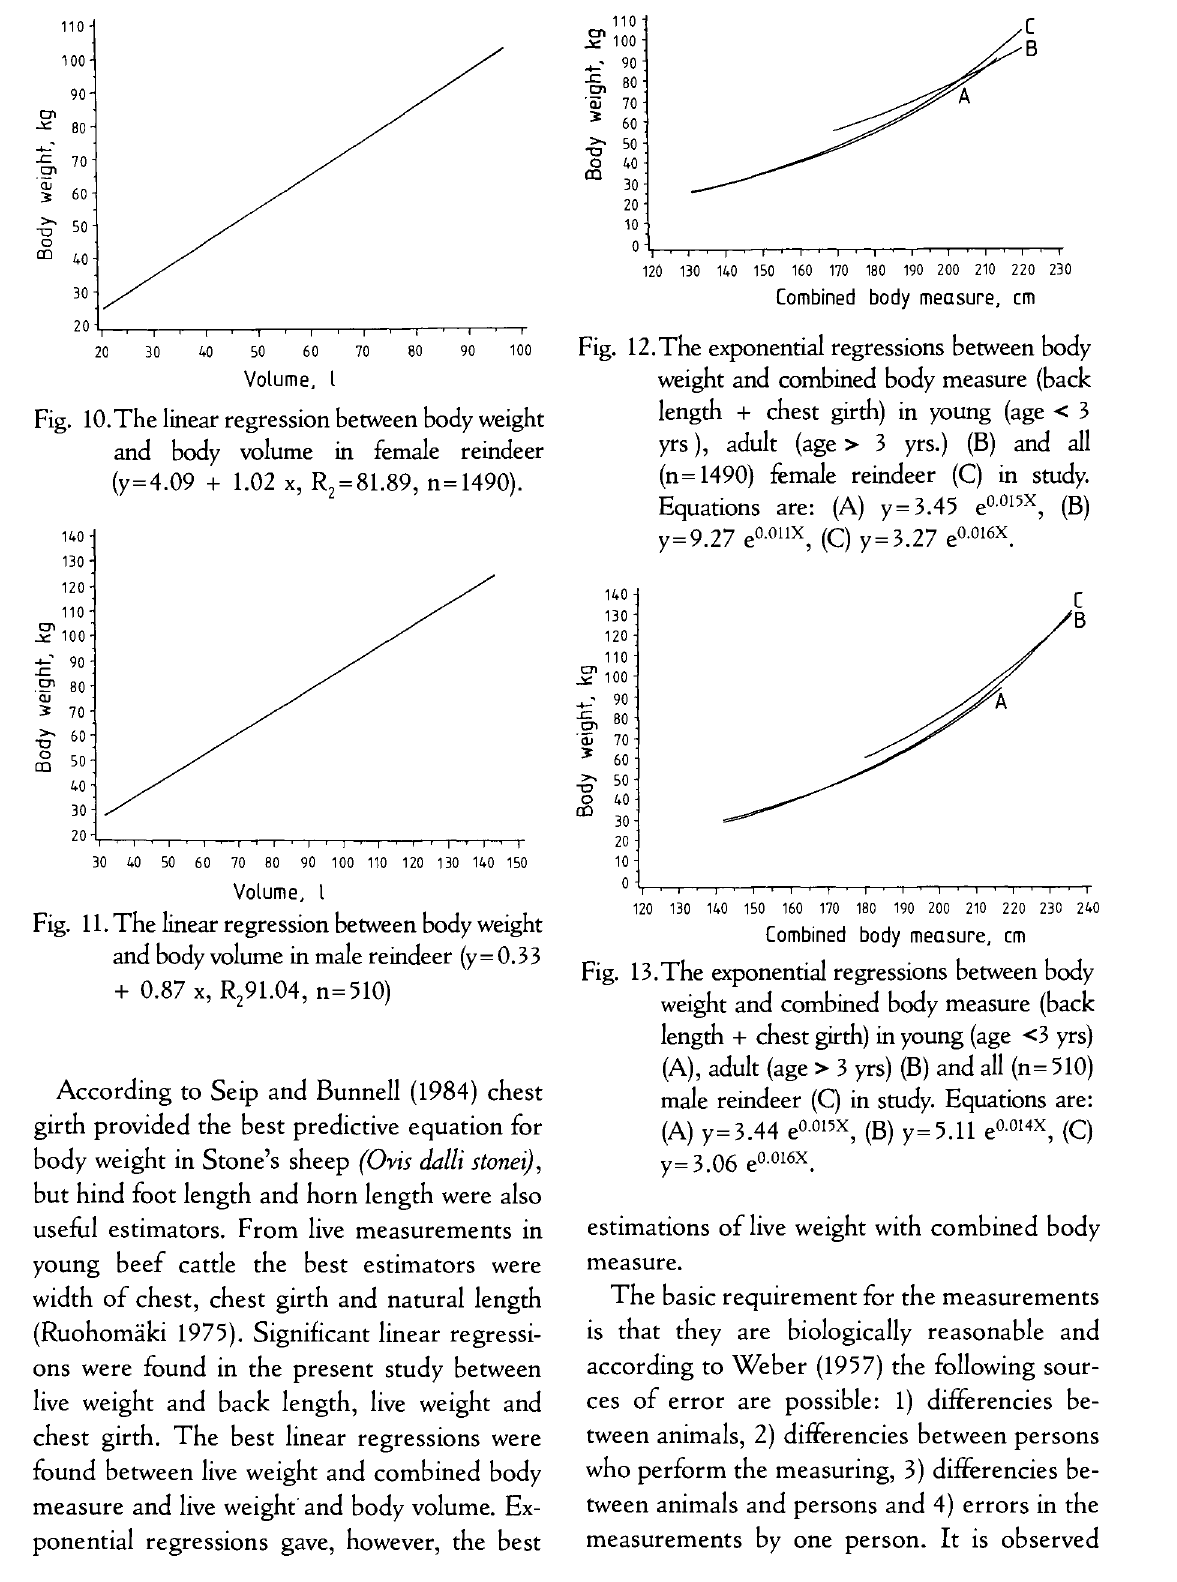
Fig. 12.The exponential regressions between body weight and combined body measure (back length + chest girth) in young (age < 3 Fig. 10.The linear regression between body weight yrs), adult (age > 3 yrs.) (B) and all and body volume in female reindeer (n=1490) female reindeer (C) in study. (y=4.09 + 1.02 x, R = 81.89, n=1490). 2 Equations are: (A) y=3.45 e 00I5X , (B)